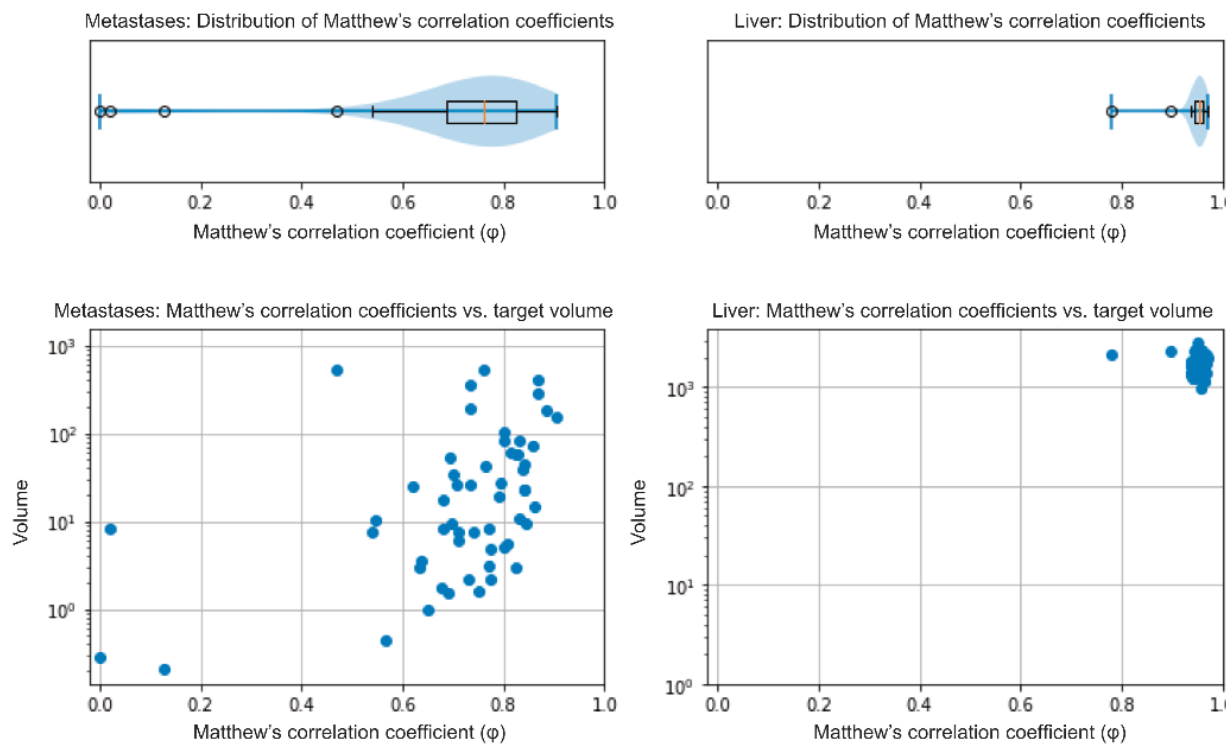
Figure 1. Internal validation–distribution of φ in NELM and liver segmentations (upper row) and its distribution in correlation to the target volume in cm 3 (lower row).